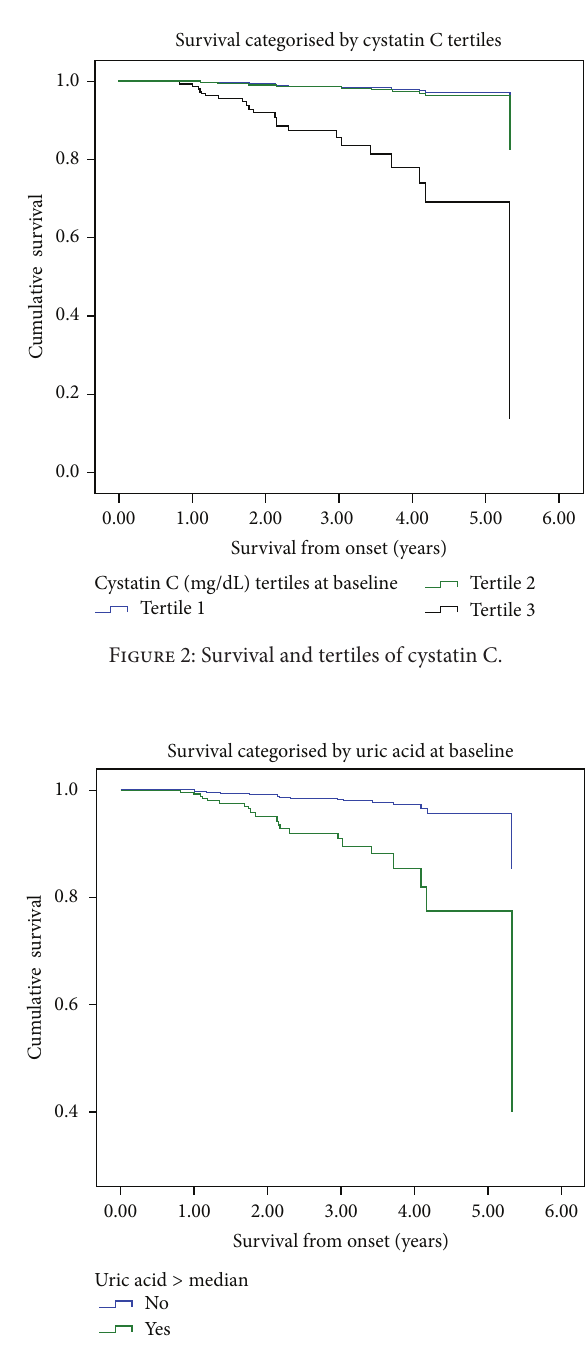
Figure 3: Survival and baseline uric acid